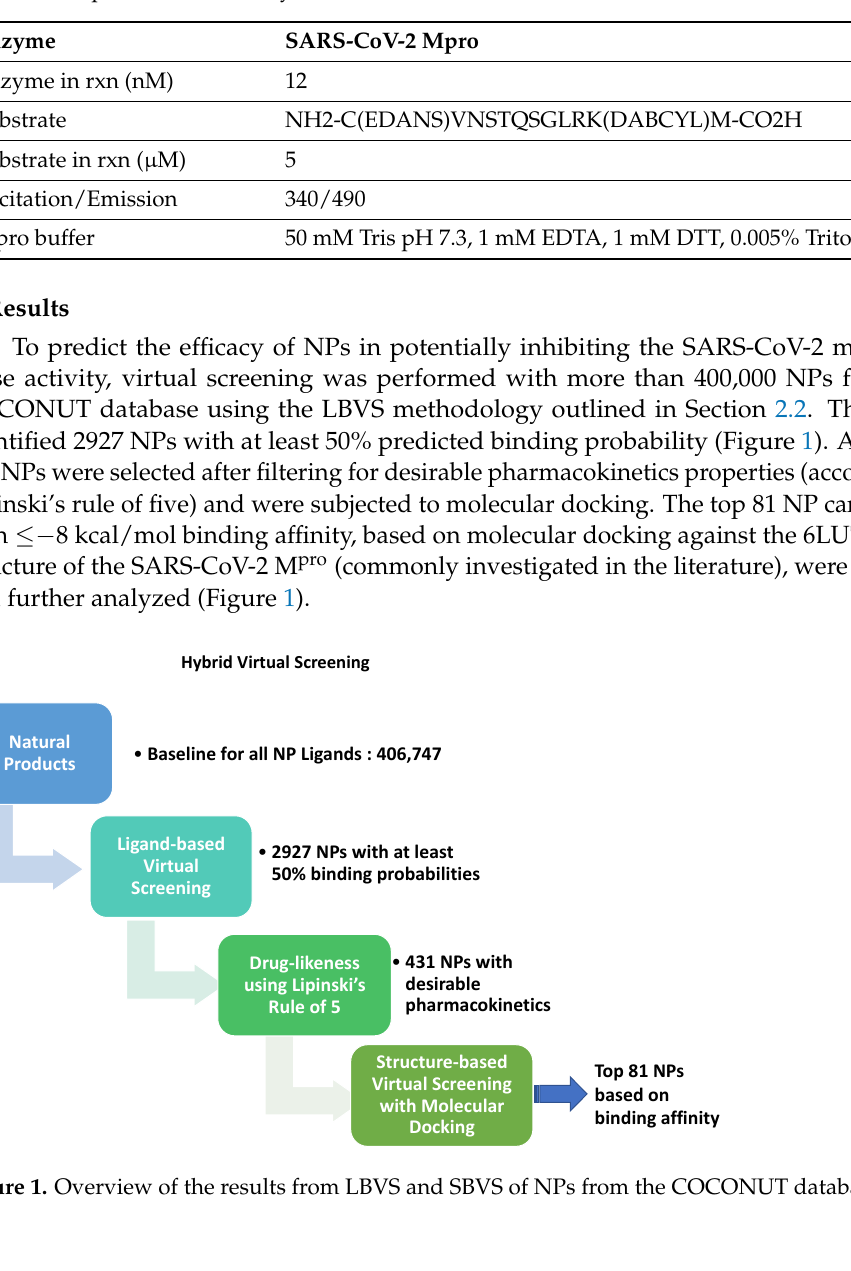
Table 2. Components of the assay.